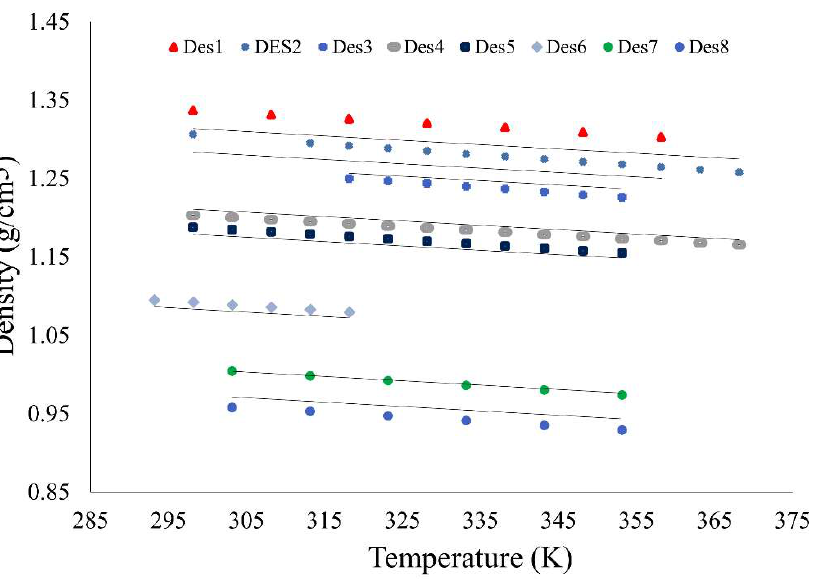
Figure 6. Comparison of densities calculated by the MO59 model to data in the literature, in temperature range from 283.15 K to 373.15 K for eight random DES at atmospheric pressure. DES1: choline chloride- D -fructose (1:1), DES2: methyltriphenyl phosphonium bromide-glycerol (1:2), DES3: acetylcholine chloride-D-fructose (1:1), DES4: choline chloride-glycerol (1:3), DES5: choline chloride-glutaric acid (1:1), DES6: choline chloride-phenol (1:3), DES7: tetrabutylammonium chloride-L-arginine (7:1), DES8: tetrabutylammonium chloride-L-aspartic acid (11:1).